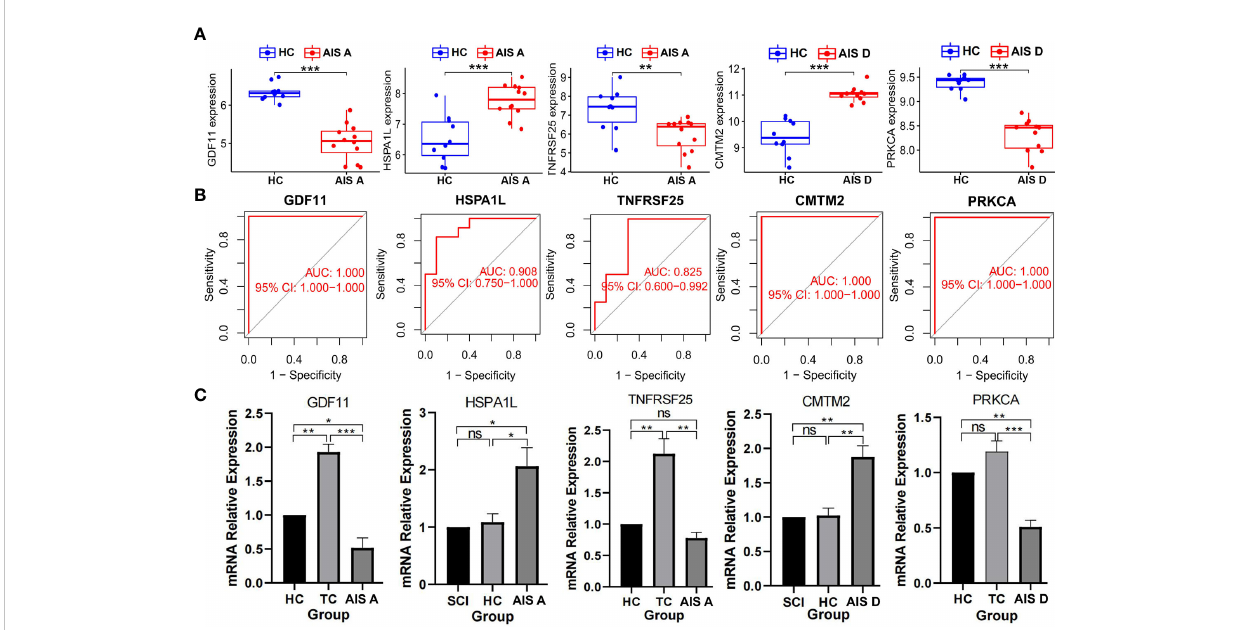
FIGURE 7 Detection of biomarkers of the AIS A and AIS D grades of SCI. (A) Expression of biomarkers between different grades of SCI and HC groups in the dataset. (B) Validation of the diagnostic value of biomarkers. (C) Expression levels of biomarkers detected by qPCR. Values are expressed as the means±SEM. n=3 for each group. Student ’ s t-test was used. ***P < 0.001; **P < 0.01; *P < 0.05; ns, no signi fi cance. A P value <0.05 was regarded as statistically signi fi cant. SCI, spinal cord injury; HC, healthy uninjured control; TC, trauma control with noncentral nervous system injury; AIS, American Spinal Cord Injury Association Impairment Scale; AUC, area under the curve; qPCR, quantitative polymerase chain reaction.